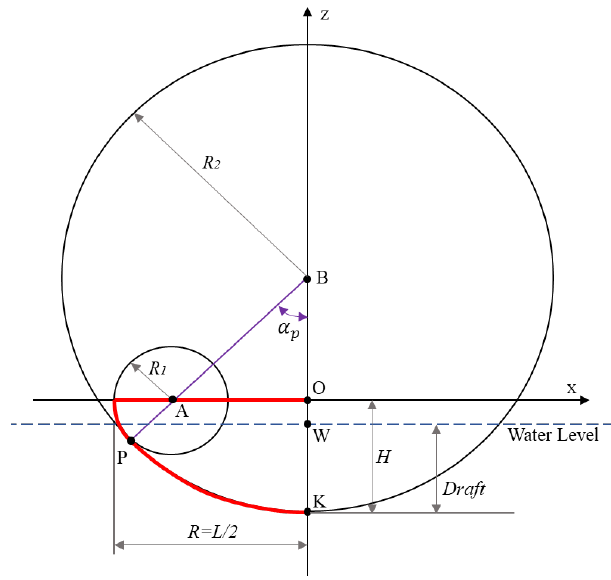
Figure 5. Parametric definition of the cross sectional of the